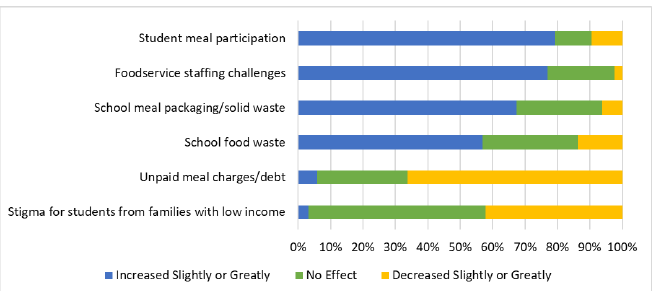
Figure 2. Changes reported after implementing universal school meals in the SY 2021–22 by Californian school food authorities ( n = 360 to 359 depending on missingness of responses; excluded SFAs implementing universal school meals to all schools through CEP or another provision). Stratified analyses among SFAs not previously implementing USM in all schools through CEP or another provision showed that increases in student meal participation, foodservice staffing challenges, and waste (both school meal packaging/solid and food waste) were higher among SFAs with 40% or fewer students eligible for FRPM than in SFAs with more than 40% of students eligible for FRPM ( p ≤ 0.05); no differences in FRPM